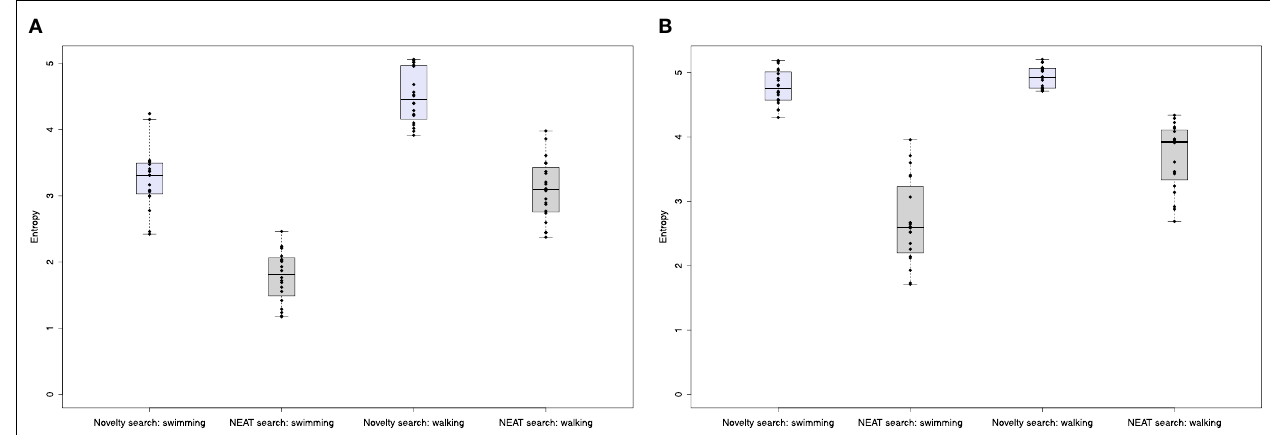
FIGURE 12 | Measuring morphological diversity: the entropy of body sizes of all viable individuals who existed over evolutionary time . The box plots show the median and quartiles for entropies calculated for 20 independent evolutionary runs of each type of experiment. Whiskers extend to the most extreme data point that is not more than 1.5 IQR from the box. Points corresponding to each experiment are overlaid. (A) Oscillator-driven actuation, (B) GRN-driven